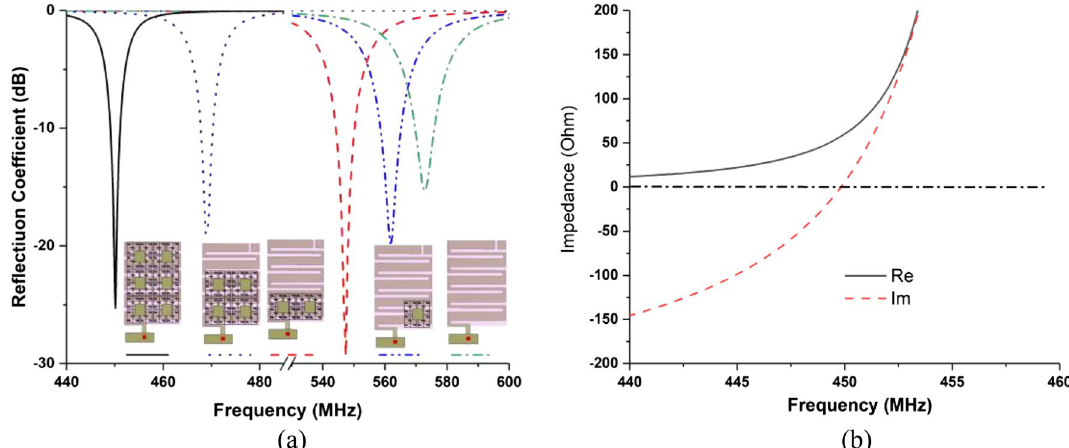
Figure 2. ( a ) Antenna reflection coefficient (S 11 ) at various stages of the proposed design, ( b ) input impedance curve of the proposed antenna.